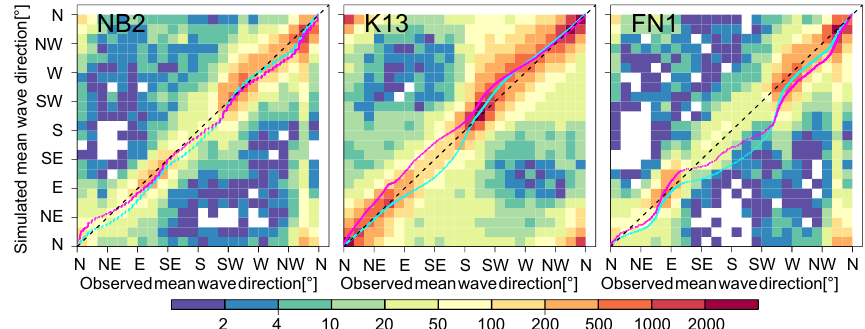
Figure 9. Scatter and quantile–quantile plot of mean wave direction between in situ observation ( x -axis) and coastDat2 hindcast data ( y -axis). Coloured squares indicate the number of counts in each 15 ◦ × 15 ◦ bin. Coloured dots represent the percentile values of the quantile–quantile plots between observed and coastDat2 hindcast mean wave directions (cyan) and between observed and ERA-Interim mean wave directions (magenta). Note that the comparison is made for different periods according to data availability (see Table 1).